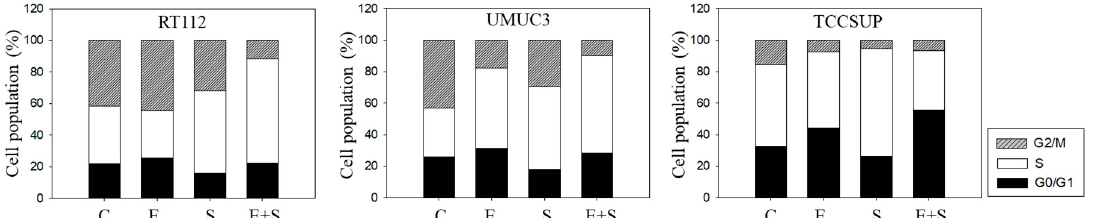
Figure 3. Cell cycle analysis—short-term treatment of synchronized cells with 0.5 nM everolimus (E) or 2.5 µ M sulforaphane (S) or 0.5 nM everolimus + 2.5 µ M sulforaphane (E + S). Untreated cells served as controls (C). Percentage of RT112, UMUC3, or TCCSUP cells in G0 / G1, S and G2 / M-phase is indicated. Inter-assay variation <10%, intra-assay variation <40%.